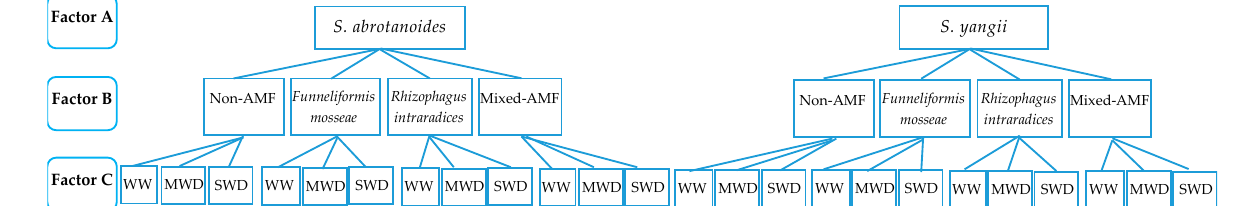
Figure 1. The schematic representation of the experimental design used in this study. WW = well-watered, MWD = moderate water deficit, SWD = severe water deficit. Non-AMF = without inoculation with arbuscular mycorrhizal fungi.